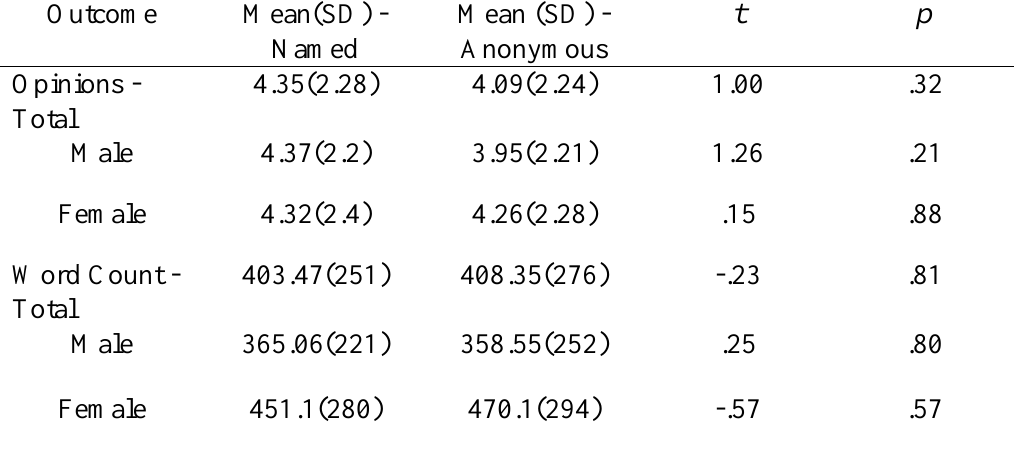
Table 2. Paired T-test Comparisons across Named and Anonymous Conditions Outcome Mean(SD) - Mean (SD) - t p Named Anonymous Opinions - 4.35(2.28) 1.00 .32 Total